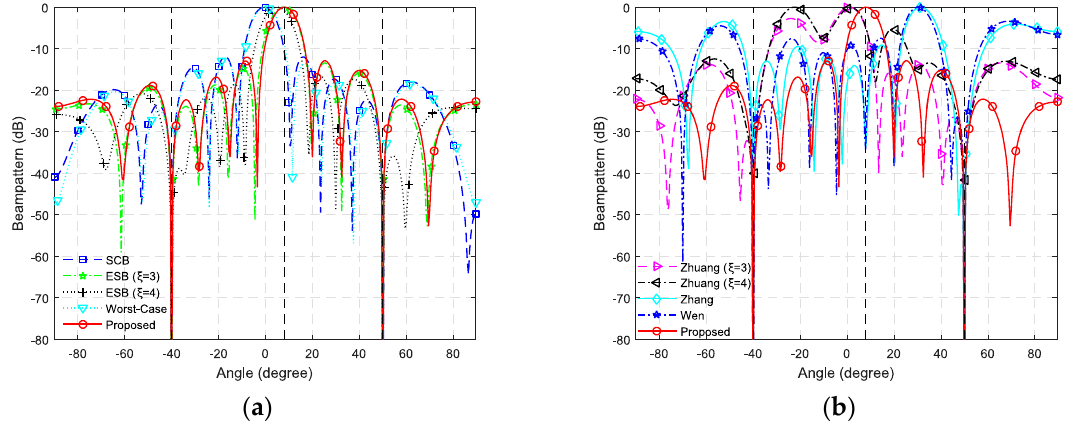
Figure 4. The resultant beampatterns for SNR = − 15 dB. ( a ) The beampatterns of SCB, ESB, Worst-Case and the proposed beamformer; ( b ) The beampatterns of Zhuang’s, Zhang’s, Wen’s and the proposed beamformer.